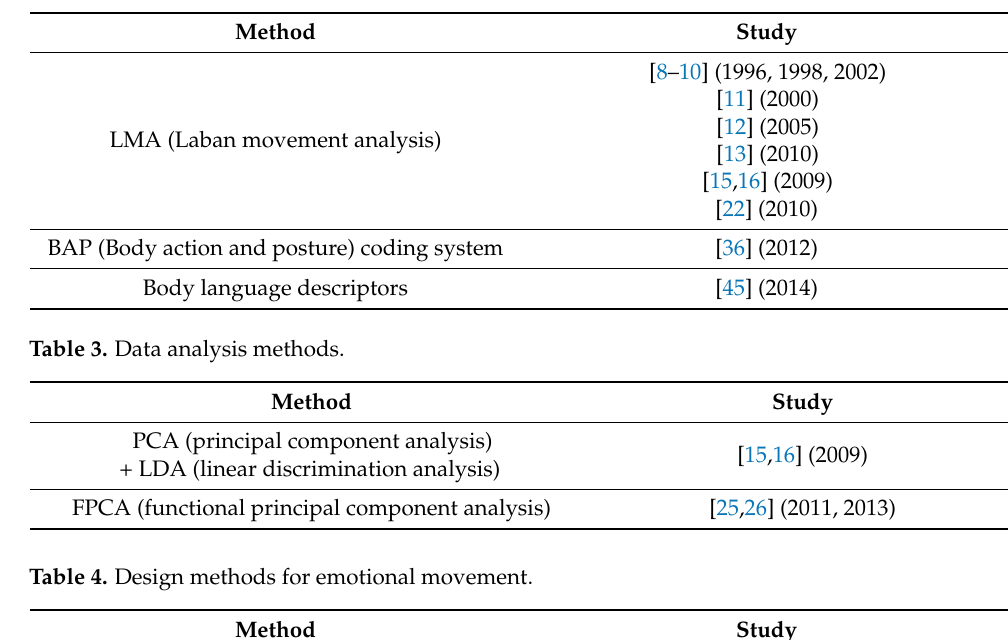
Table 2. Description of methods to mimic human behavior.